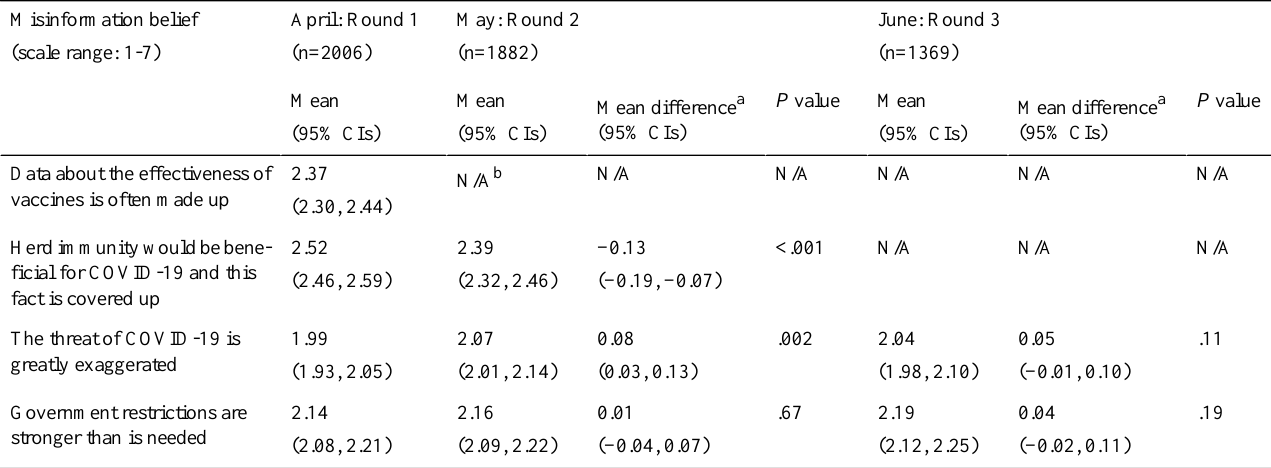
June: Round 3 (n=1369)May: Round 2 (n=1882)April: Round 1 (n=2006)Misinformation